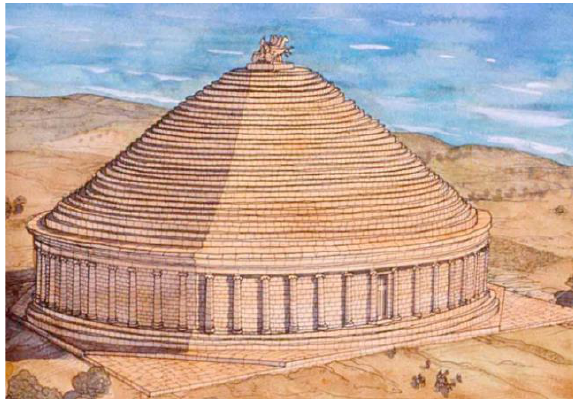
Figure 1. Restitution of the Mausoleum according to J.-C. Golvin, (Blas De Roblès, Sintes, 2003, p.